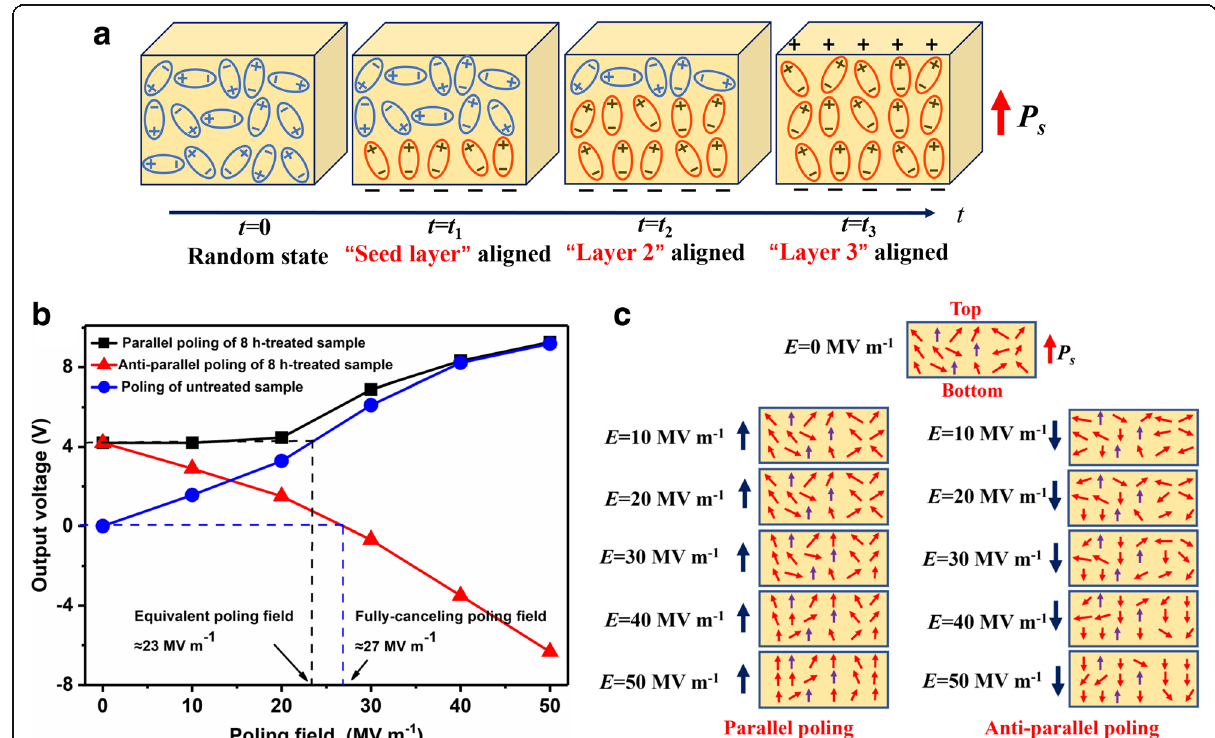
Fig. 3 a Dipoles alignment relay process in PVDF triggered by the hydrophilic groups among the substrates. b Influences of thermal poling field and direction on pyroelectric responses of 8-h treated sample. c Schematic diagram of parallel and anti-parallel